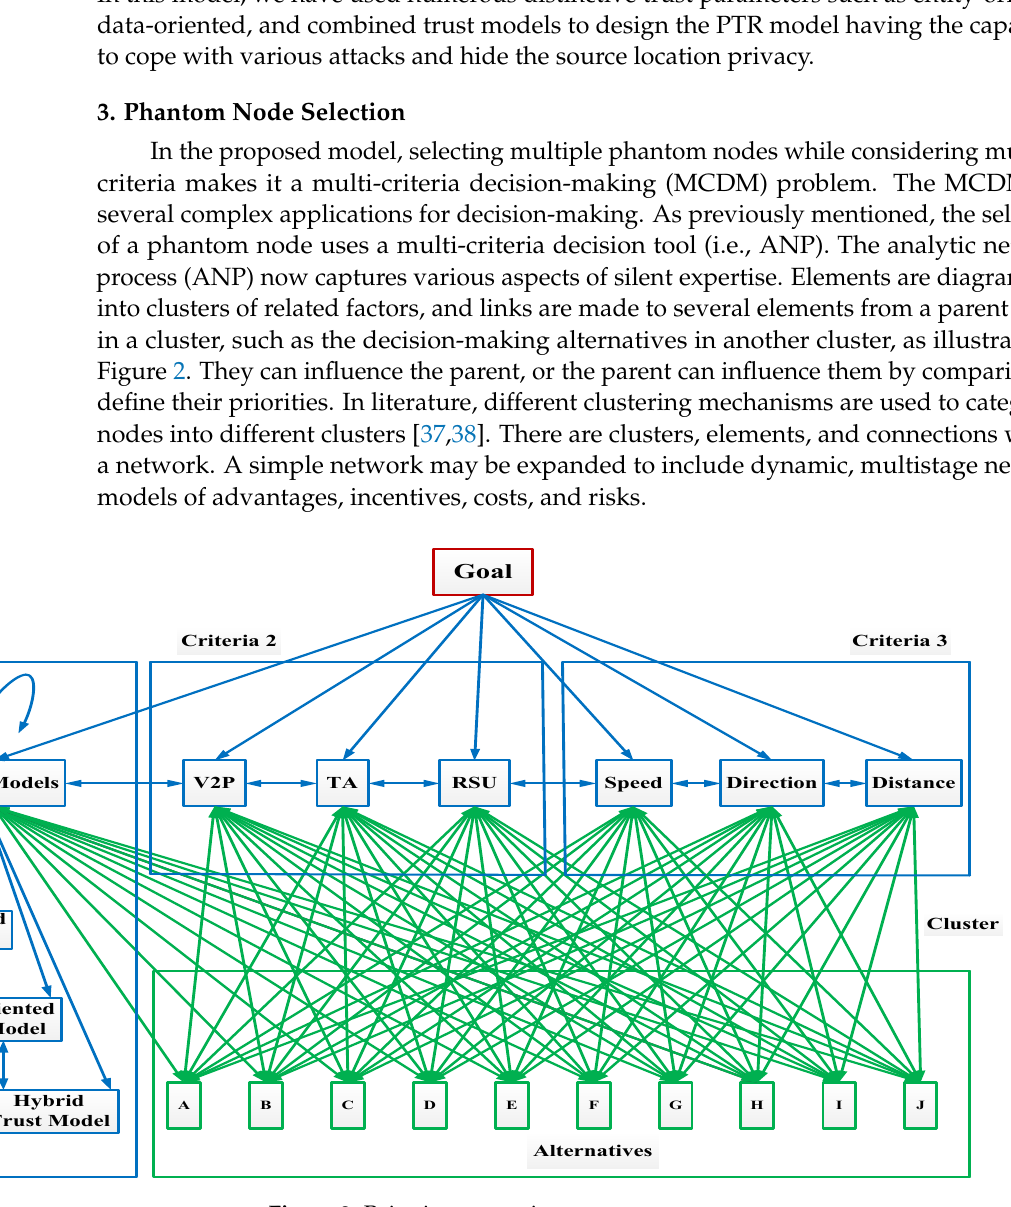
Figure 2. Pairwise